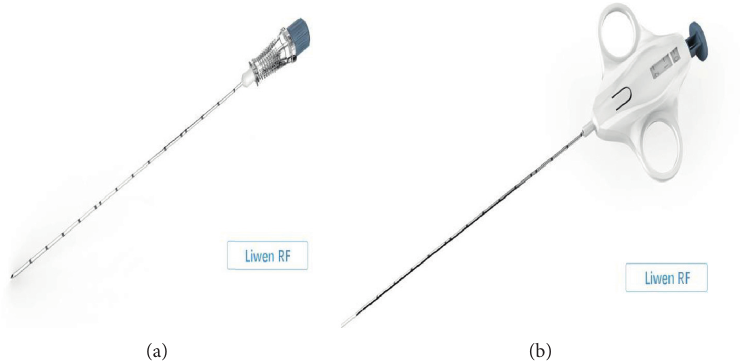
Figure 1: Myocardial biopsy needle of the Liwen procedure. The biopsy needles were 1.27mm in diameter with adjustable front-end lengths of 10mm and 20mm, respectively. (a) Cardiac puncture sheath. (b) Cardiac biopsy